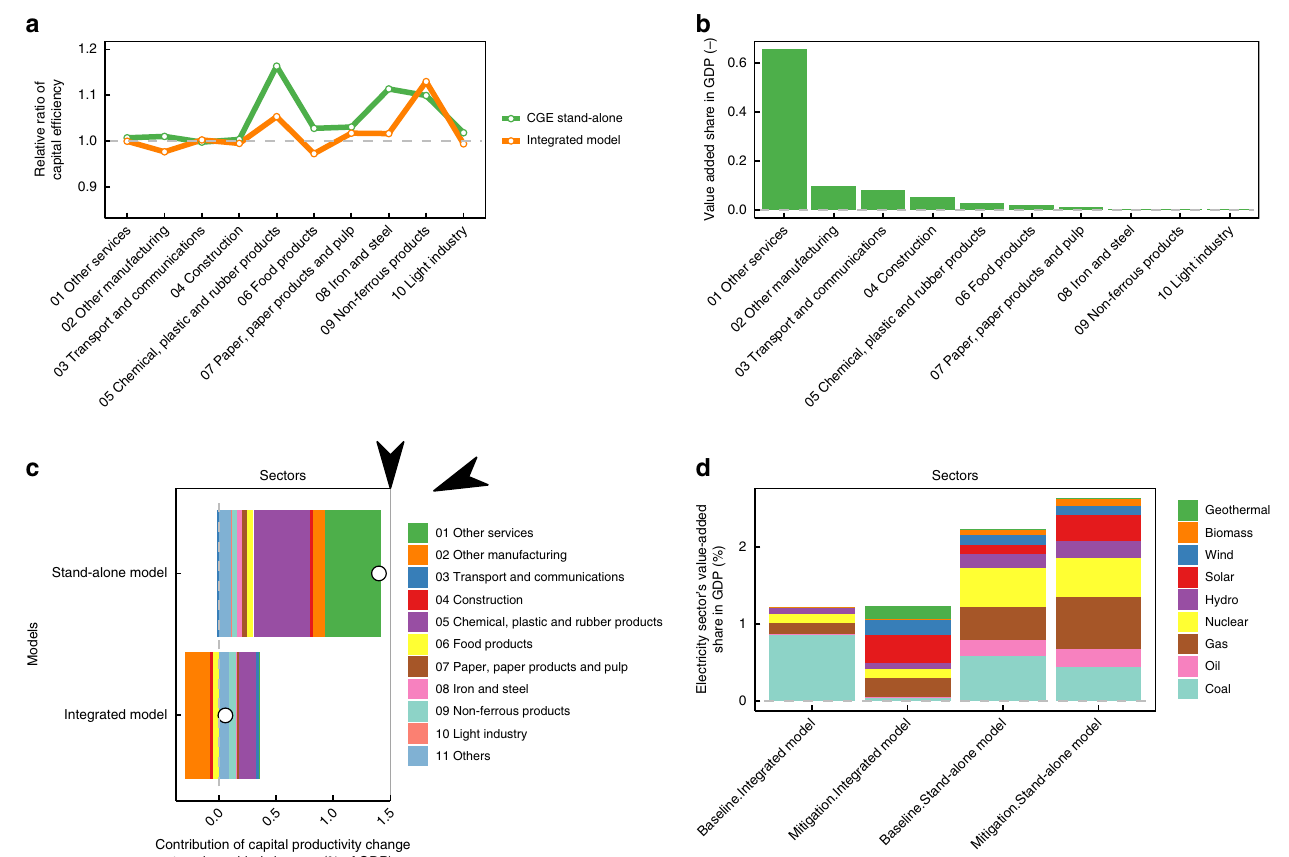
Fig. 4 Valued-added differences between baseline and mitigation scenarios. a Sectoral capital input ef fi ciency for the top 10 industrial activities in 2050. Capital ef fi ciencies in baseline and mitigation scenarios are computed and then the capital ef fi ciency in the mitigation scenario relative to the baseline scenario is shown. b Sectoral value-added share in the baseline scenario for the top 10 industrial activities. c The capital productivity value-added effects compared to the total value-added for the top 10 industrial activities. Dots means net total changes. Negative and positive values mean capital productivity gain and losses compared to baseline scenarios respectively. d The value-added share of power sectors in terms of total economy-wide